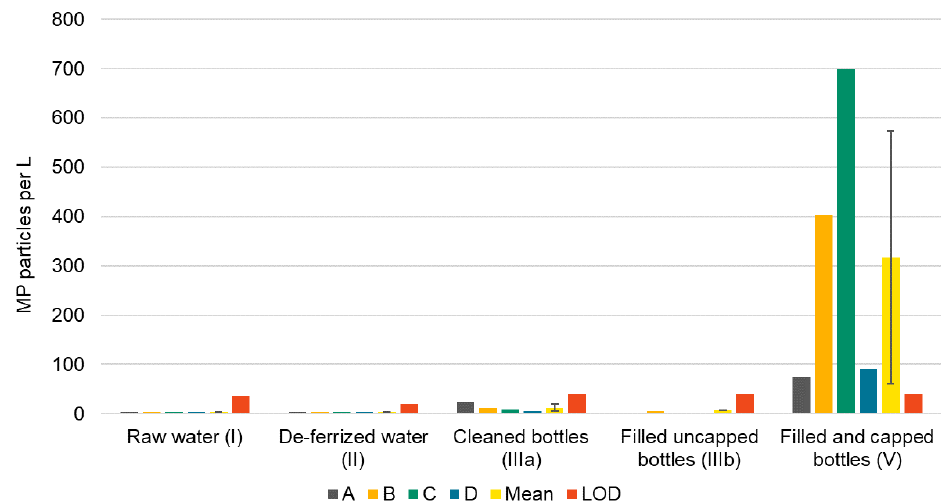
Figure 4. MP concentrations per L mineral water along the bottling process of four bottling sites (A–D), corresponding mean (error bars indicate standard deviation) and LODs for each sample type.